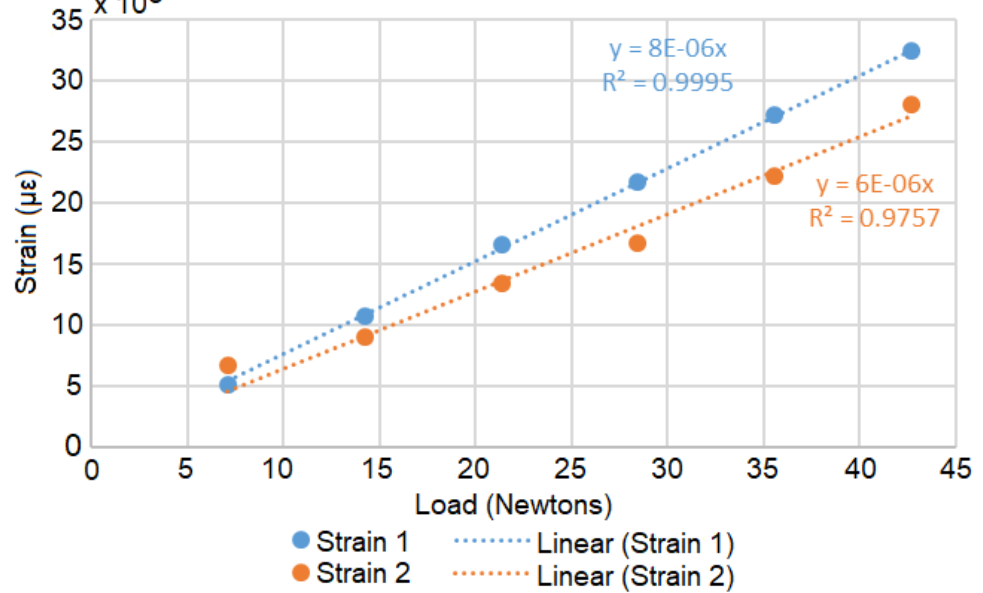
Figure 6. The processed average loads with minimum least squares regression